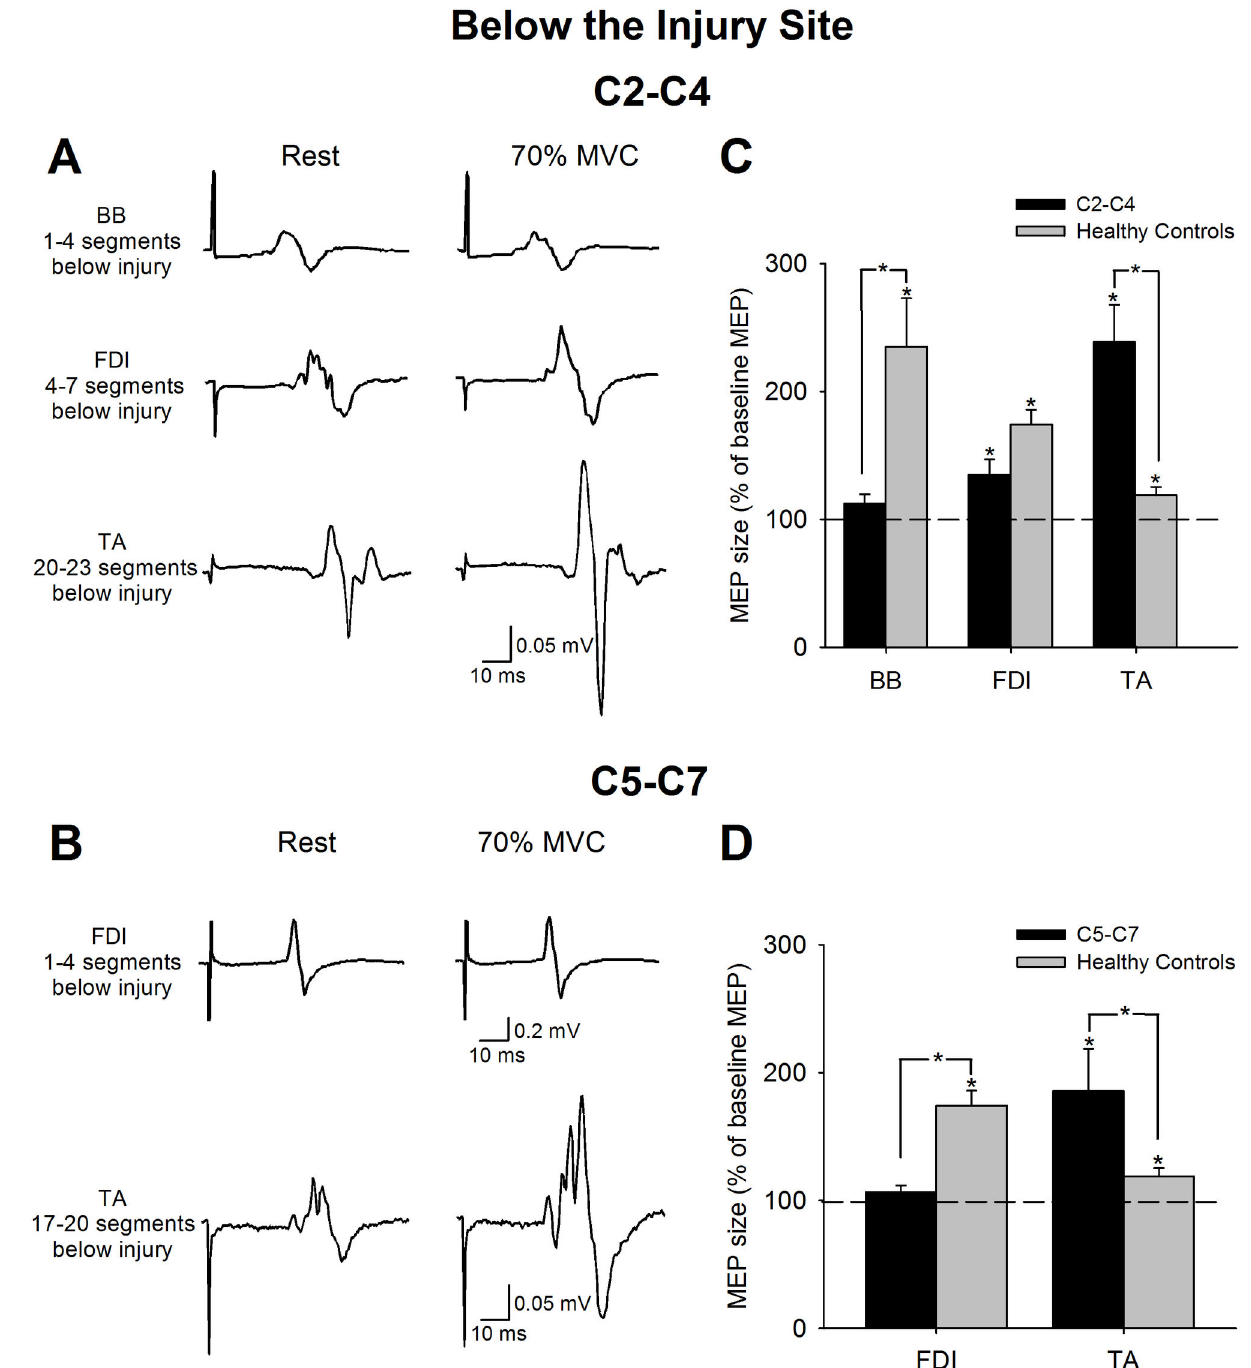
Figure 3. MEPs below the injury site. MEPs recorded from the resting BB, FDI, and TA of representative patients with a C2-C4 (A) and C5-C7 injury (B), while the other side remained at rest or performed 70% of index finger abduction, elbow flexion, or ankle dorsiflexion. Group data (C, healthy controls, n=17 and C2-C4, n=7; D, healthy controls, n=16 and C5-T7, n=11). The abscissa shows the muscle tested (BB, FDI, and TA). The ordinate shows the size of BB, FDI, and TA MEPs as a % of the baseline BB, FDI and TA MEPs. Note the increase in FDI and TA MEP size during contralateral index finger abduction and elbow flexion, but not in BB MEPs during elbow flexion in patients with C2-C4 injuries. Interestingly, TA MEPs size was increased in both groups of patients more than in healthy controls. Error bars indicate SEs. *p < 0.05.